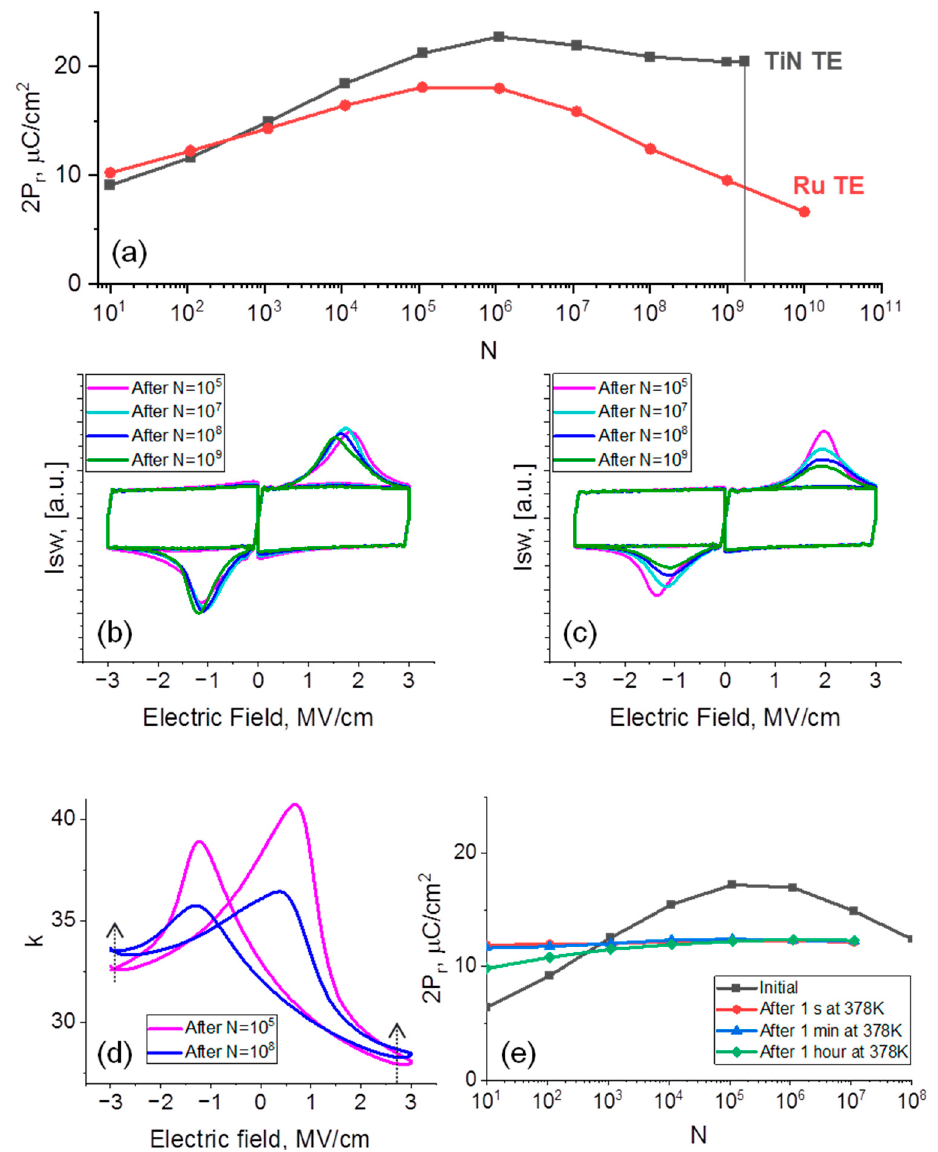
Figure 4. ( a ) 2P r as a function of the number of switching cycles measured from devices with TiN and Ru TE at RT; dynamic I sw -E curves measured after N = 10 5 , 10 7 , 10 8 and 10 9 from devices with TiN ( b ) and Ru ( c ) TE; k -value dependence on E, extracted from the small-signal measurements of the device with Ru TE after N = 10 5 and 10 8 ( d ), inset: dependence of k -value at 3 MV/cm on N; ( e ) results of polarization recovery test: initially recorded endurance up to N = 10 8 ended up with the decrease in 2P r, i.e., fatigue and endurances measured after the baking of the fatigued device at 105 °C during different baking times.